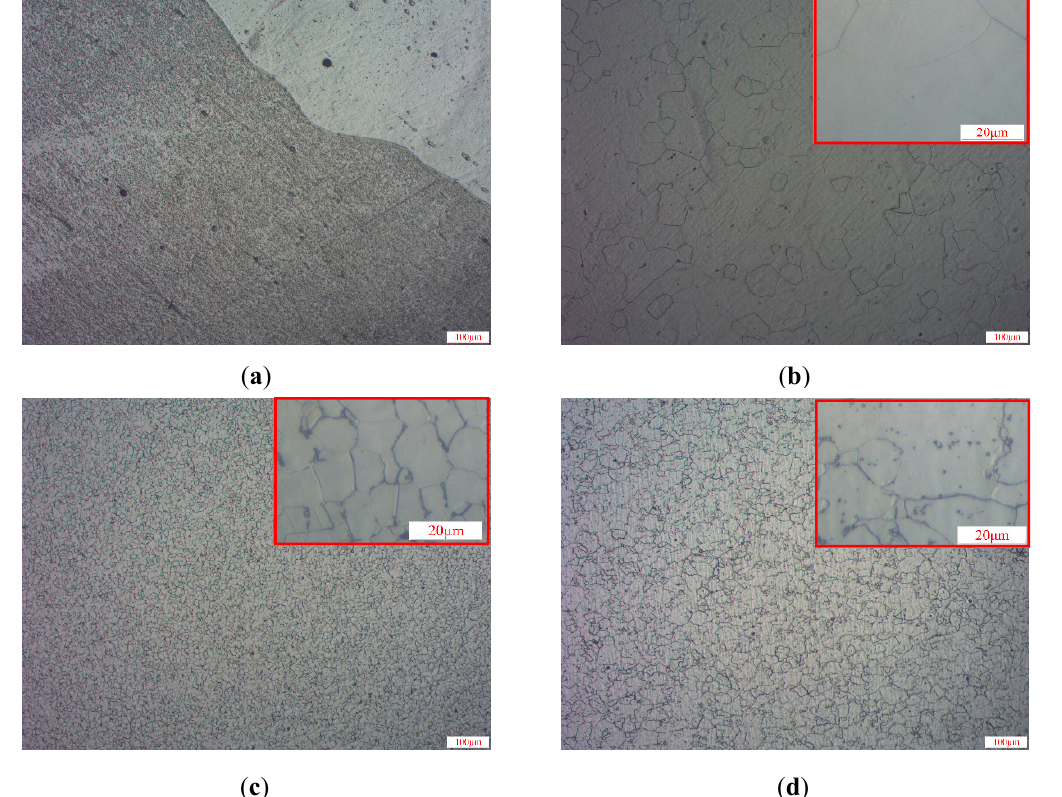
Figure 11. Optical micrographs of the microstructures of 4 materials: ( a ) 30SQG120, ( b ) B50A470, ( c ) X60, and ( d ) X70.